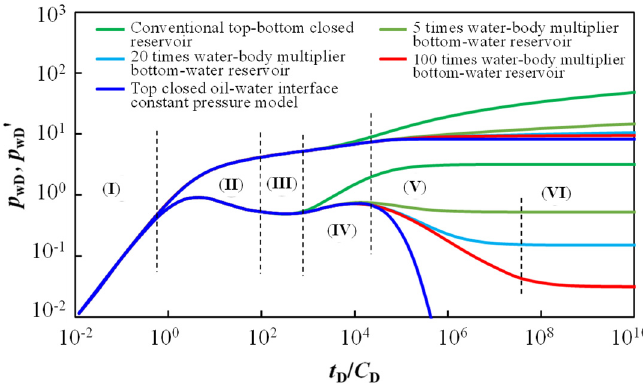
Figure 3. Typical pressure curves of a horizontal well in a bottom-water reservoir with a finite body of water.